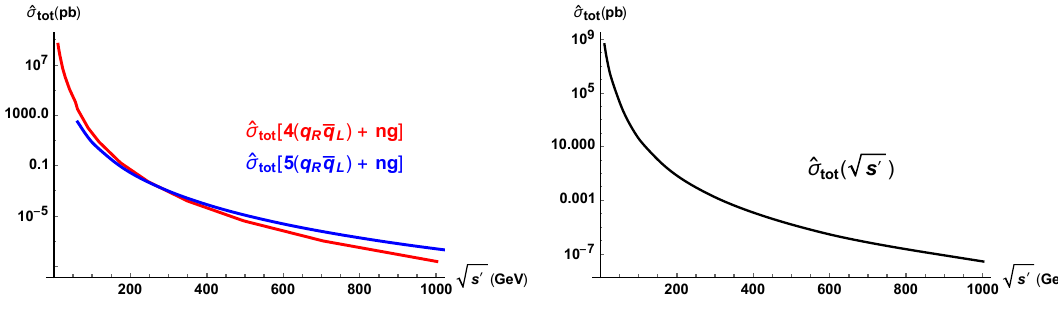
p s 0 . The plot on the